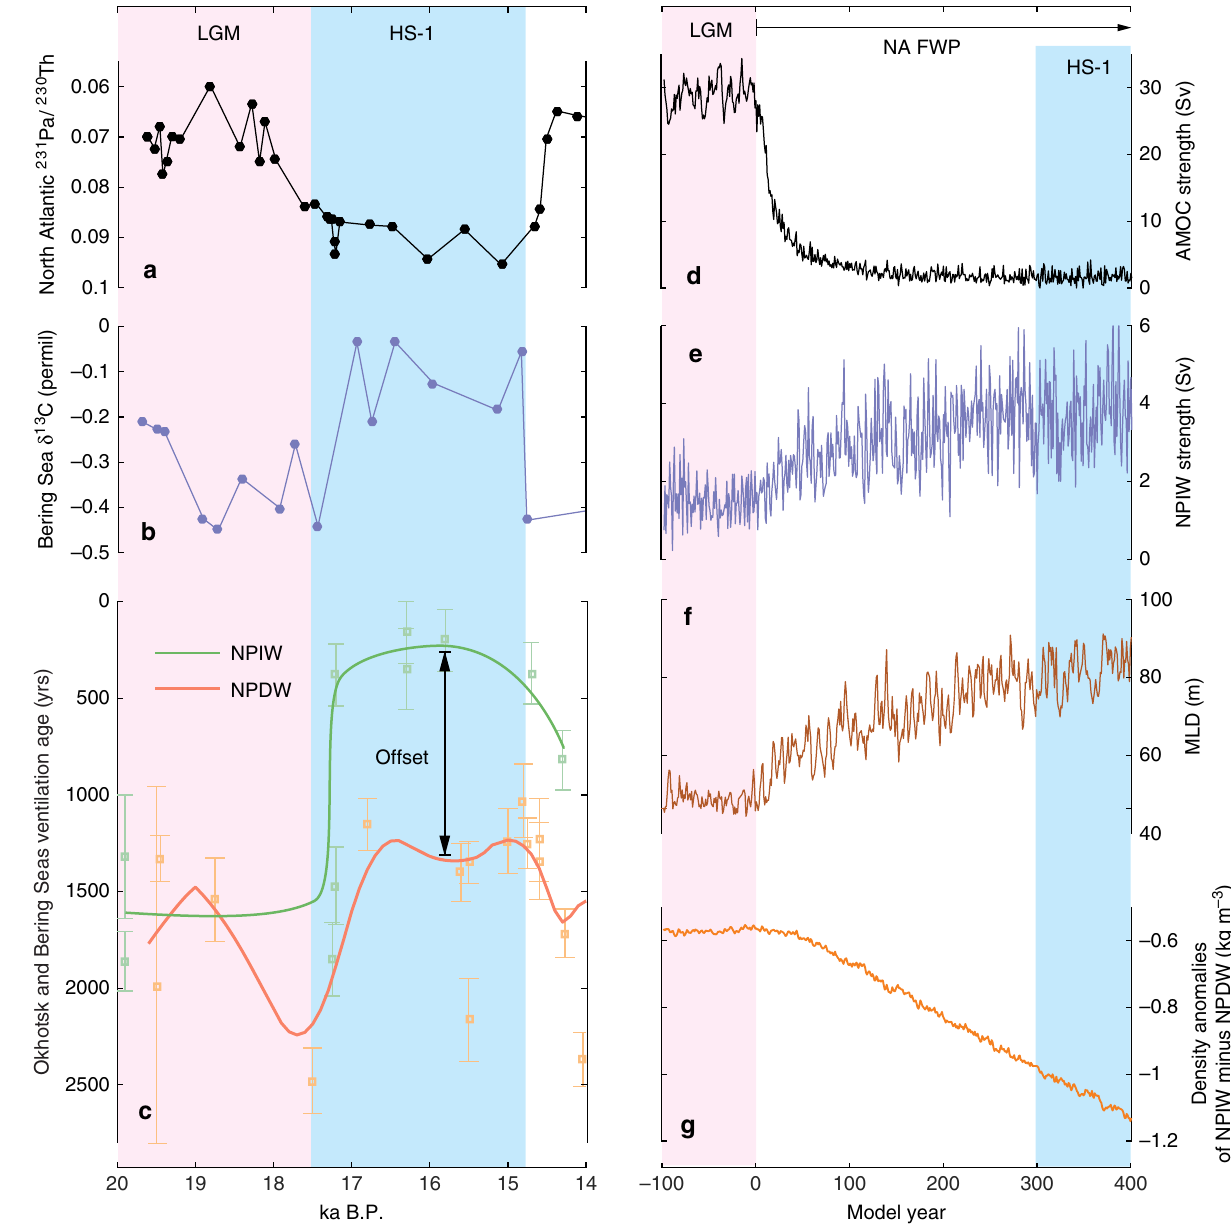
Fig. 1 Collected proxy records and the modelling results in this study. a Reconstructed AMOC change on the basis of sedimentary 231 Pa/ 230 Th ratio; 3 b Benthic foraminiferal δ 13 C records at the intermediate depths of the Bering Sea, with higher values for stronger NPIW formation; 15 c NW Paci fi c intermediate and deep-ocean ventilation ages, with the error bars from radiocarbon measurements; 15 d Modelled AMOC strengths; e Modelled NPIW strengths; f Modelled annual mean MLD in the middle of Okhotsk and western Bering seas; g Modelled subarctic Paci fi c NPIW (at 1000 m) and NPDW